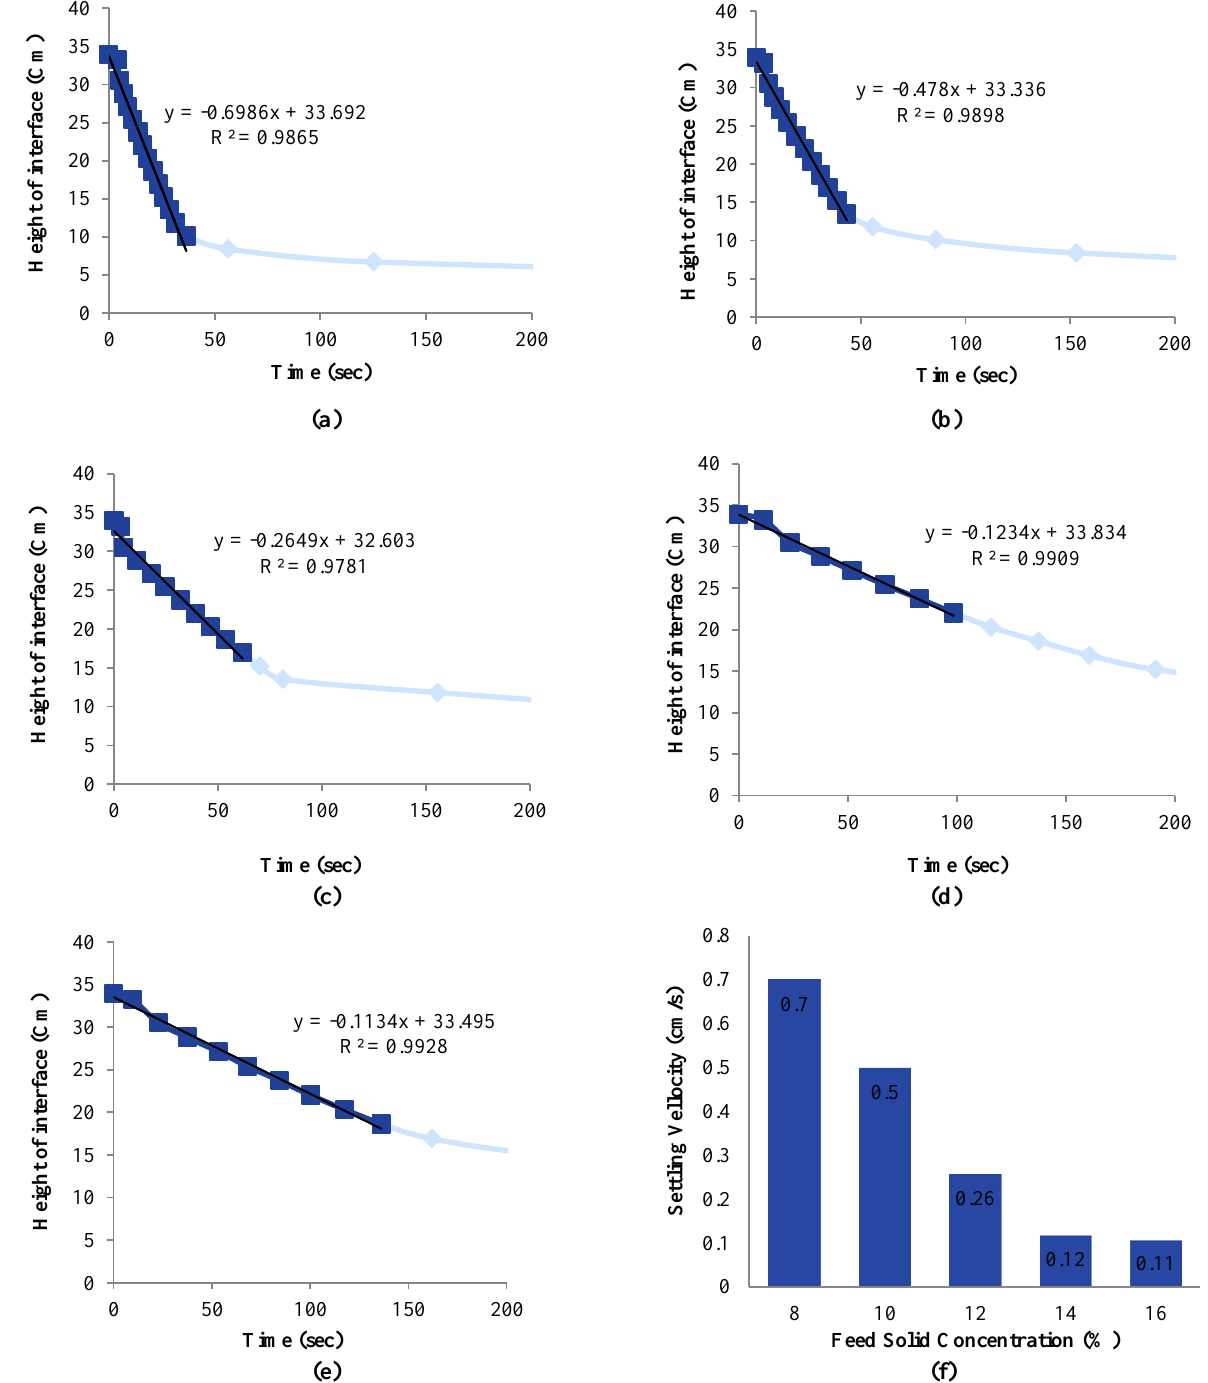
Figure 2. The variation of the height of the goal and the settling rate of pulp solids in flocculant content (a to